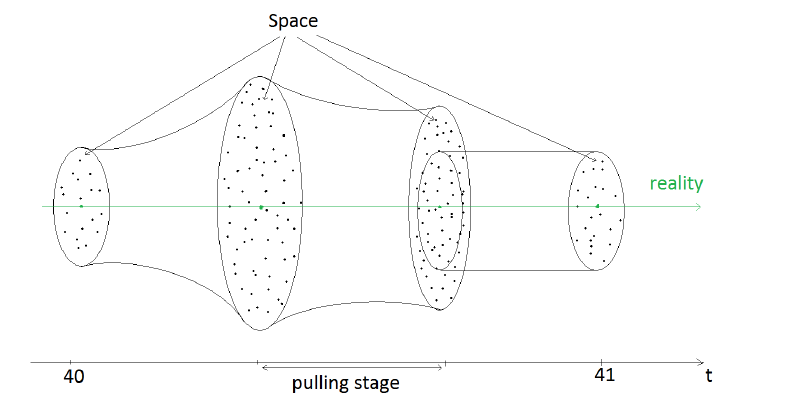
Figure 3. Schematic diagram of method : We depict moving from frame 40 to frame 41 of the video, with time t labeled along the horizontal axis. The disk represents a small volume element inside the high-dimensional “phase space” containing all relevant measures of the system being tracked. The green dot in the center of the disk represents “reality” (e.g., positions + orientations of all cells), and the size of the disk represents the extent of observational error (e.g., video resolution). All points inside the disk thus represent plausible measurements of the real system to within observational uncertainty. The black dots are the “ensemble” of simulated universes, all assumed to be within observational uncertainty of the real system. The second, largest disk represents the expansion of the ensemble to many plausible futures—many more universes than we had at frame 40, all of them plausible future trajectories of the system, and now occupying a space much larger than the video uncertainty. Between the 2nd and 3rd disks, we perform a “pulling” operation on all the universes, by performing a preliminary fit of each one to video frame 41, which pulls them all “closer” to the reality depicted in frame 41. However, even after this pulling stage, some members of the ensemble remain implausible—outside the measurement uncertainty of video frame 41. These are discarded, giving the smaller disk at the end of the pulling stage, which is then propagated to frame 41. Finally, if there are too many members of the ensemble that remain at frame 41, we take a final sample of the “best-fitting” members to initialize the process at frame